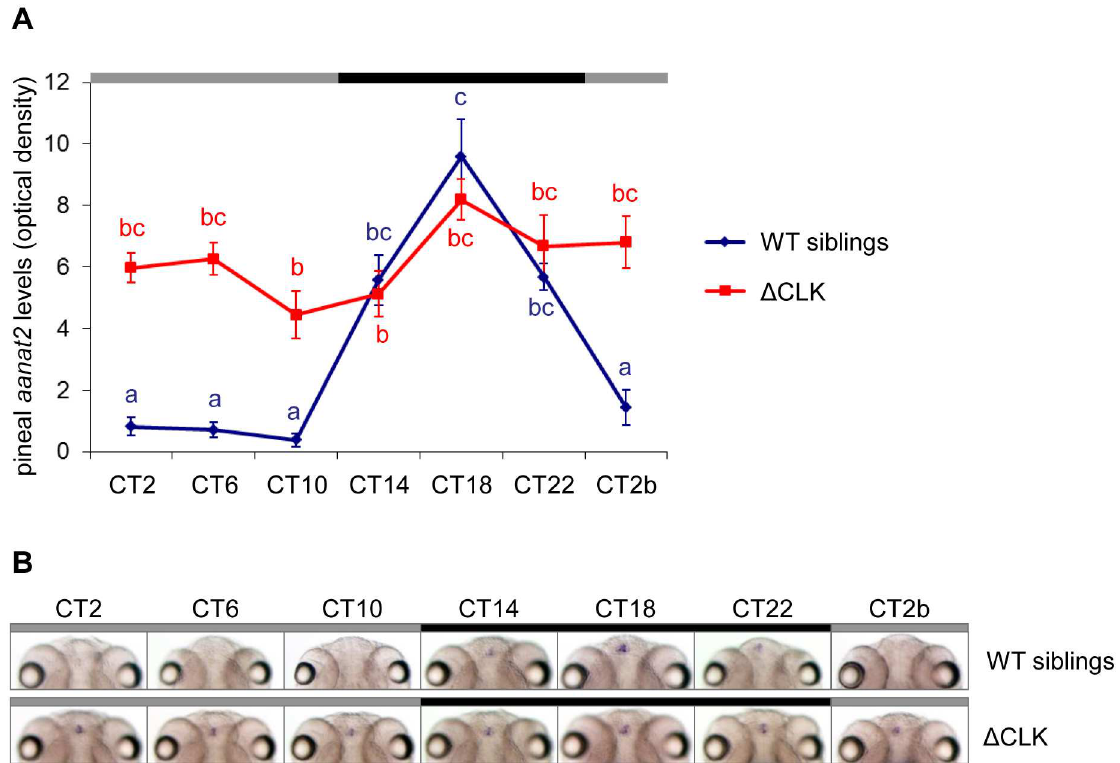
Fig 2. Clock-controlled aanat2 mRNA rhythm is abolished in the pineal gland of Tg( aanat2 :EGFP- Δ CLK) larvae. (A) Tg ( aanat2 :EGFP- Δ CLK) larvae ( Δ CLK)exhibitarrhythmic pineal aanat2 mRNA levels under DD compared with a robust rhythm in their WT siblings( p < 0.0001, two-way ANOVA), indicatingthat the pinealgland molecularclock is disrupted. Each value represents the mean opticaldensity ± SE of the pineal aanat2 whole-mount ISH signal( n = 10 − 15larvae). Different letters represent statisticallydifferent values ( p < 0.05,Tukey’s test). (B) Representative whole-mount ISH aanat2 signals(8 dpf, dorsal view) in the pinealglands of WT siblinglarvae (upper panel)and Tg( aanat2 :EGFP- Δ CLK) larvae ( Δ CLK; bottom panel). Black and gray bars represent subjective night and day, respectively.CT,